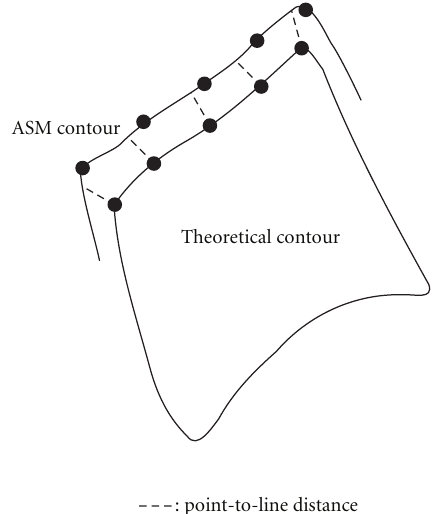
Figure 13: Point-to-line distance between 2